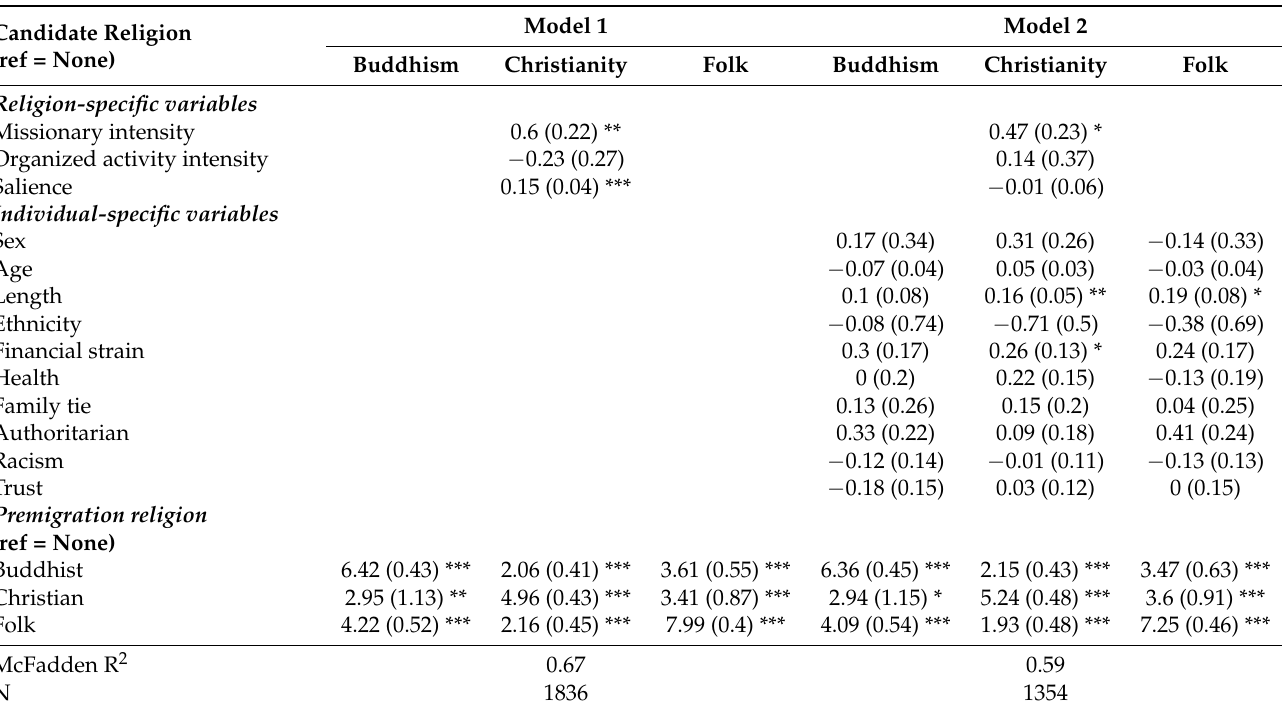
Table 6. Conditional logit model of personal religious changes between premigration religion and current